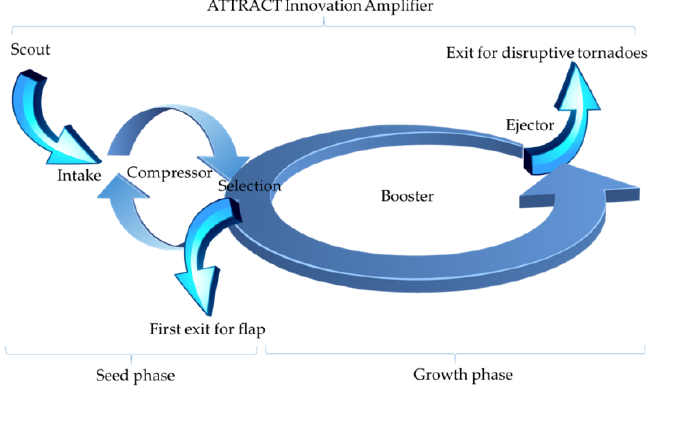
Figure 2. ATTRACT Innovation